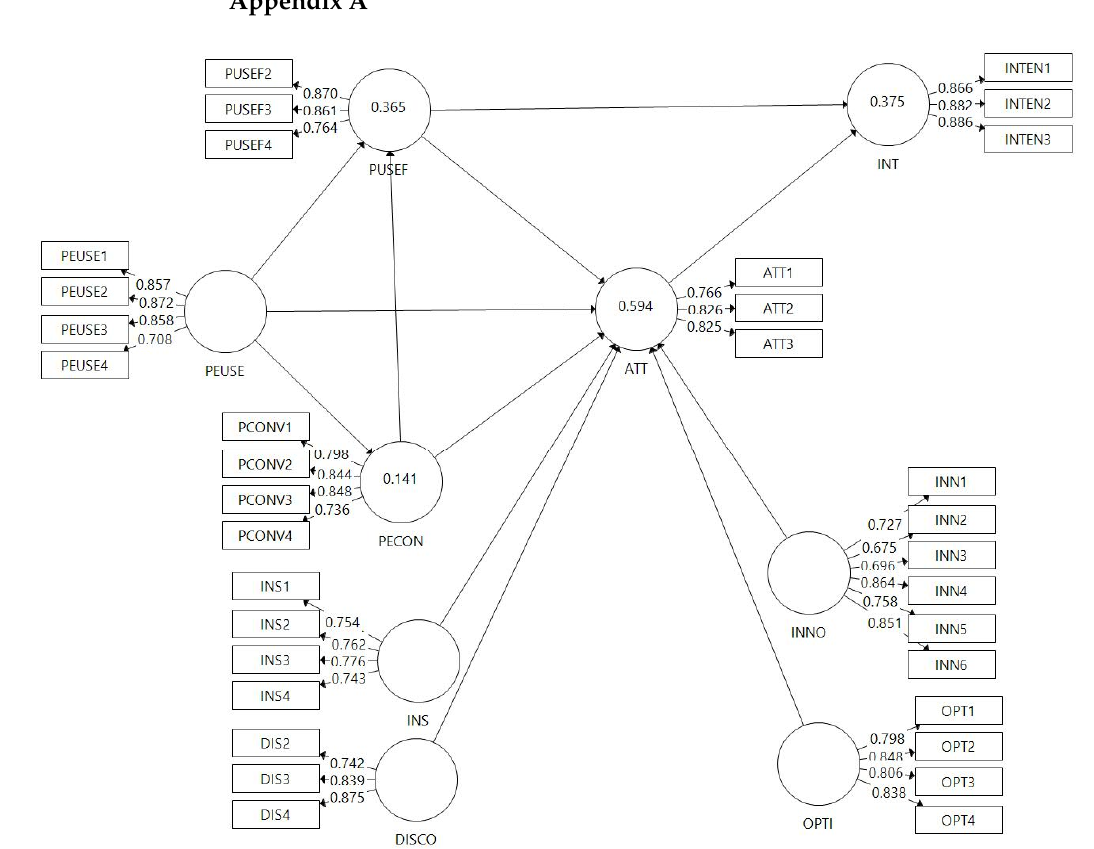
Figure A1. Measurement Model Confirming Factor Loadings.